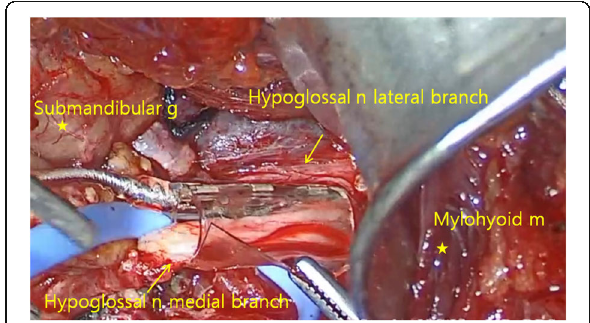
Fig. 1 Cuff electrodes encircling the medial branch of hypoglossal nerve with three stimulation nodes. Note the lateral branch is not included in the cuff. ( n nerve, m muscle, g gland)